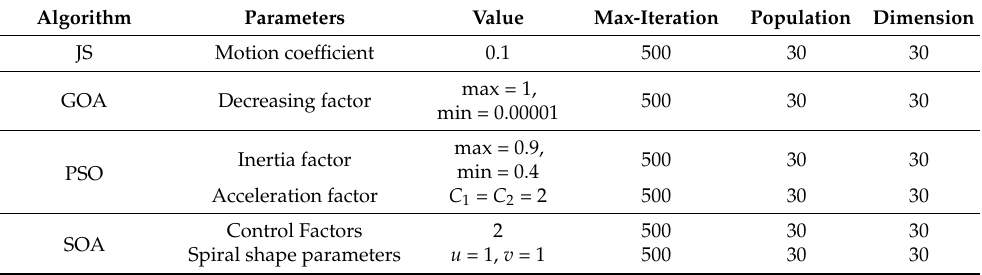
Table 2. Setting of parameters in some